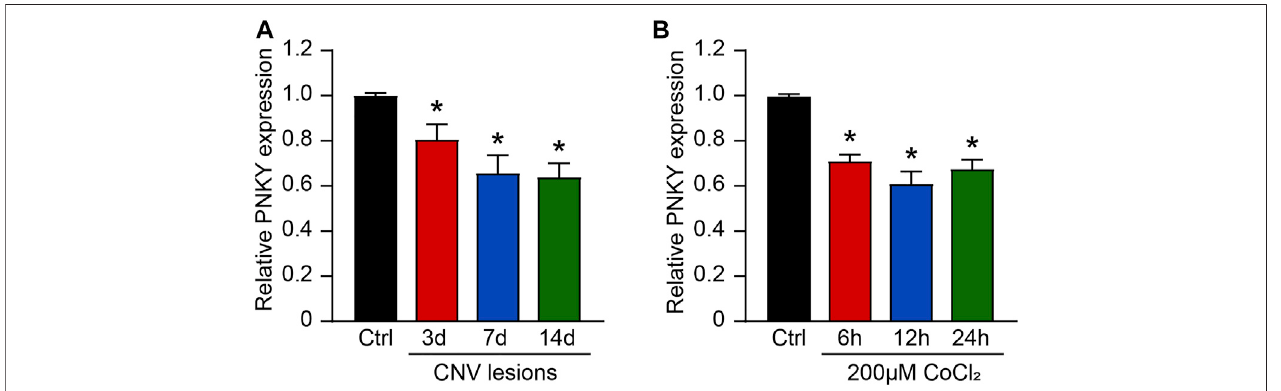
FIGURE 1 | LncRNA PNKY expression pattern in CNV lesions and in RF/6A cells under the hypoxic condition. (A) qRT-PCRs were executed to detect the level of PNKY in the choroidal samples of C57BL/6 mice after 3, 7, and 14-day laser photocoagulation ( n = 4, * p < 0.05, Kruskal – Wallis ’ test followed by Bonferroni ’ s post hoc test). (B) RF/6A cells were incubated with 200 μ M CoCl 2 for the speci fi ed time. qRT-PCRs were used to detect PNKY expression ( n = 4, * p < 0.05, one-way ANOVA followed by Bonferroni ’ s post hoc